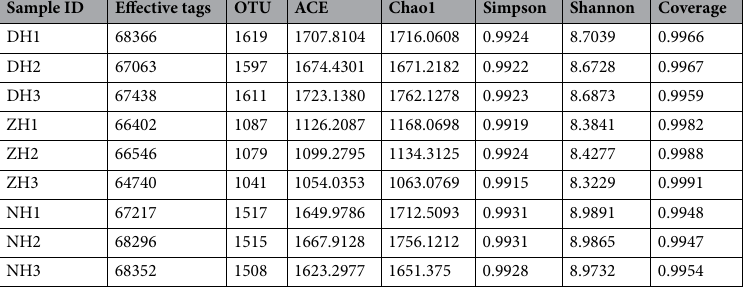
Table 2. Microorganism OTU, sequencing coverage and diversity index of sediment